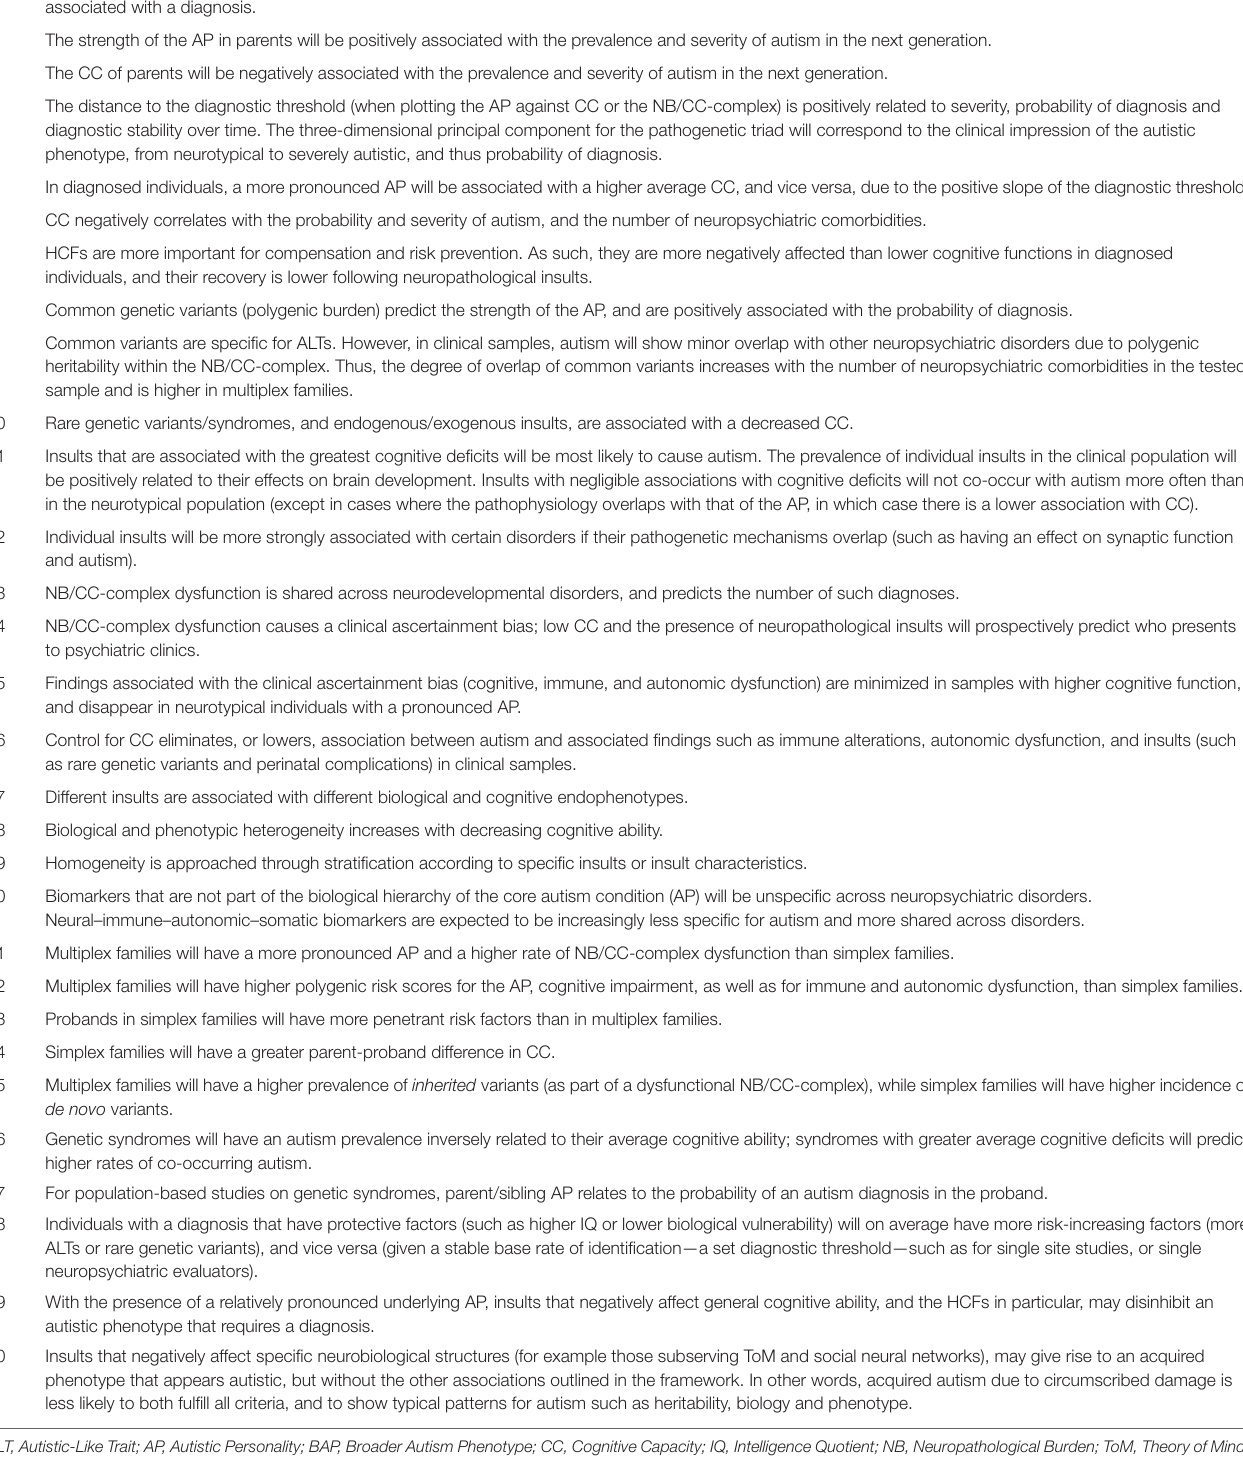
TABLE 3 | Testable postulates of the pathogenetic